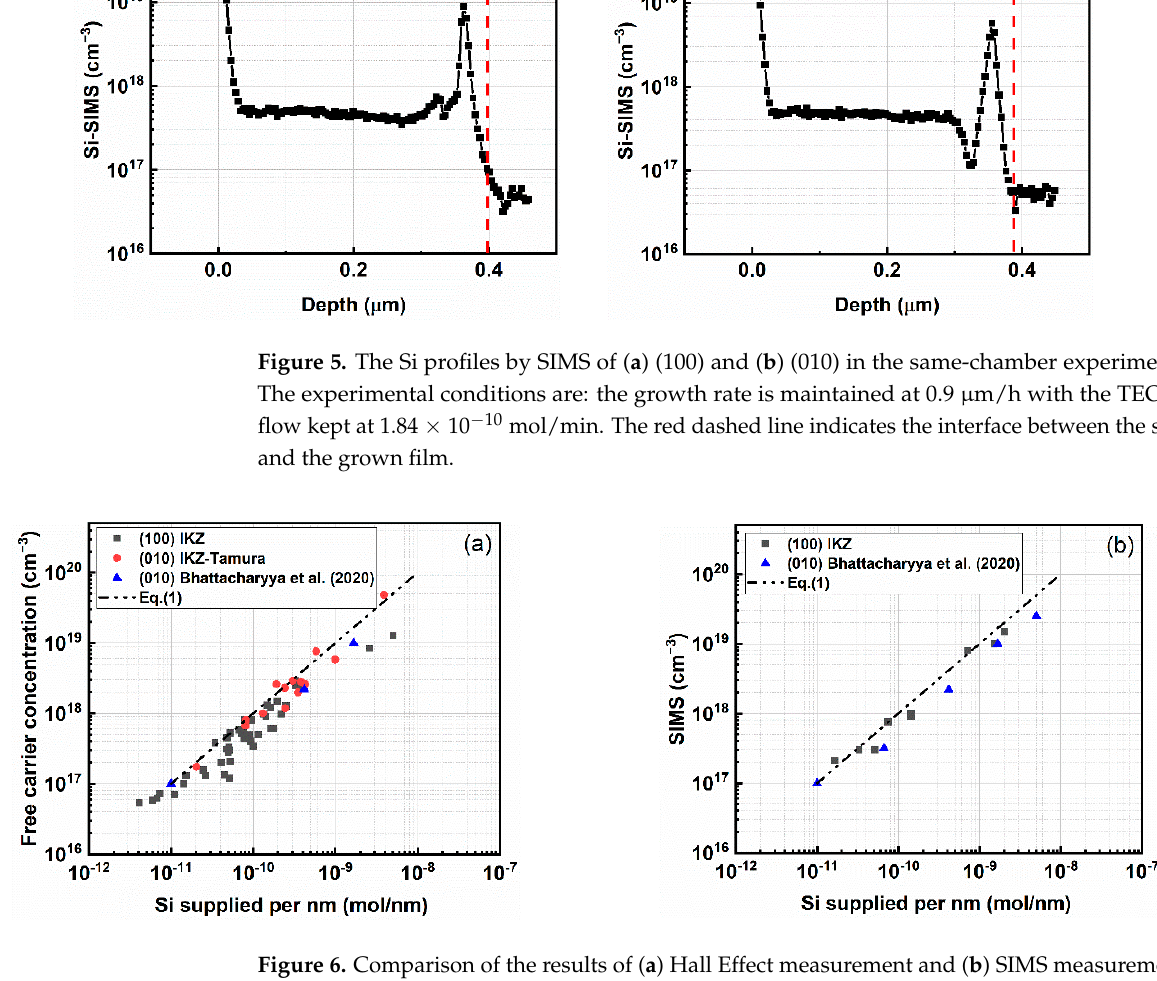
Figure 6. Comparison of the results of ( a ) Hall Effect measurement and ( b ) SIMS measurement from both (100) and (010) MOVPE-grown β -Ga 2 O 3 thin films with the Si supplied per nm (mol/nm) as the main variable.